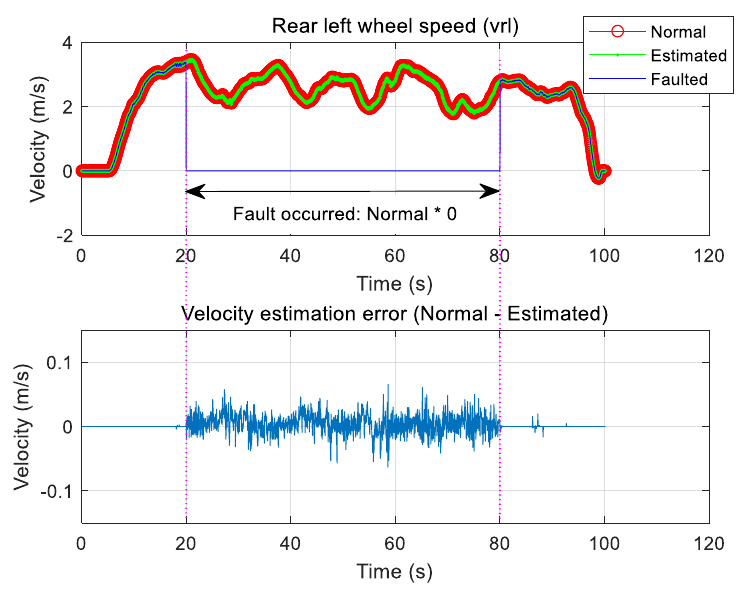
Figure 7. Type 1: Rear left wheel speed sensor fault and estimation.